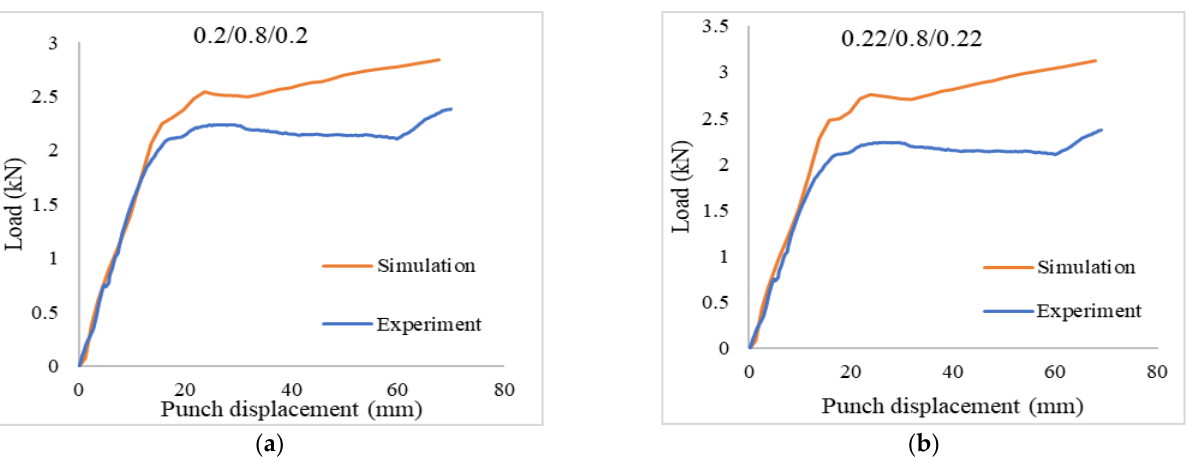
Figure 26. Comparison of load curves from experiment and simulation ( a ) 0.2/0.8/0.2 mm and ( b ) 0.22/0.8/0.22 mm thickness combinations.